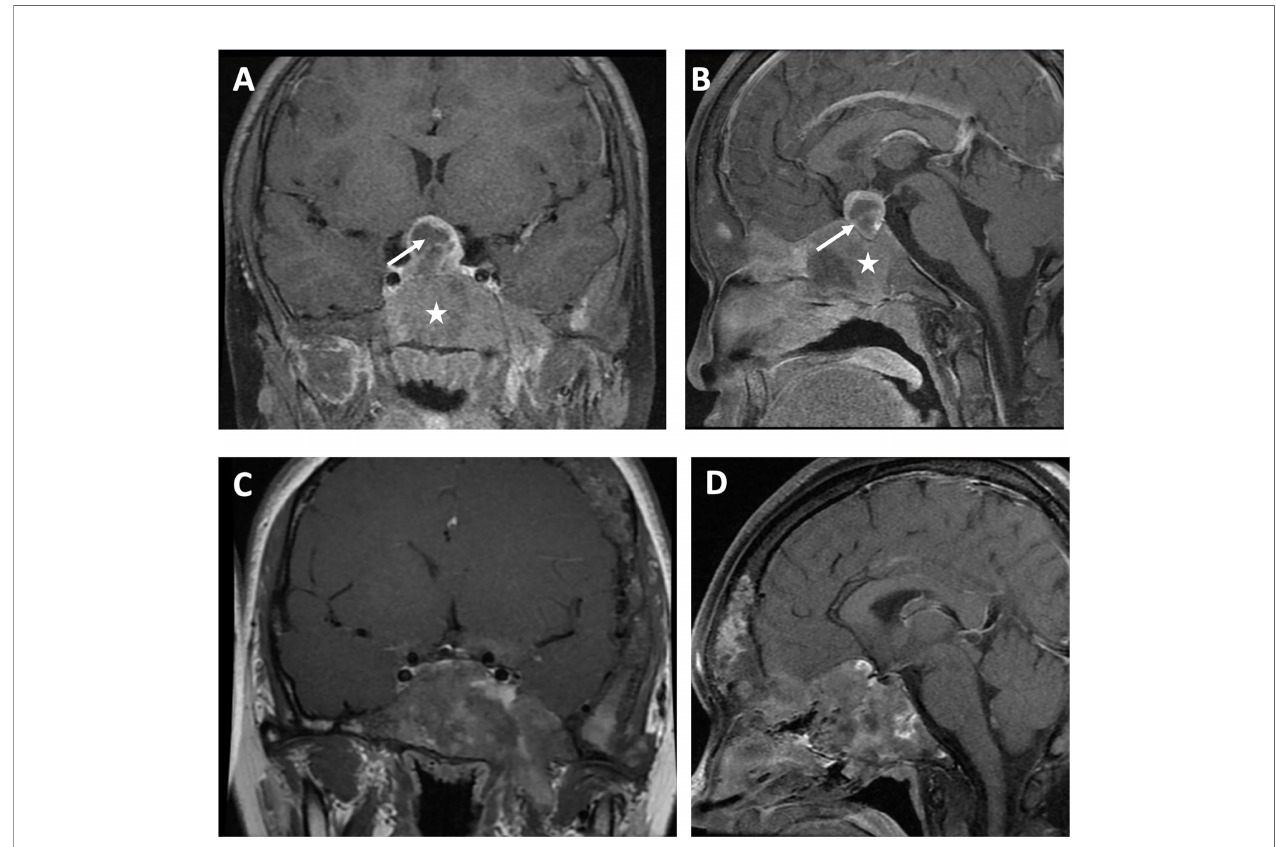
FIGURE 3 | Visualization by MRI in the coronal view (A) and sagittal view (B) of a macroadenoma (arrow) surrounded by cranial fi brous dysplasia (star) in a patient with MAS and GH excess before surgery and pharmacologic treatment. Coronal view (C) and sagittal view (D) after surgery and pharmacologic